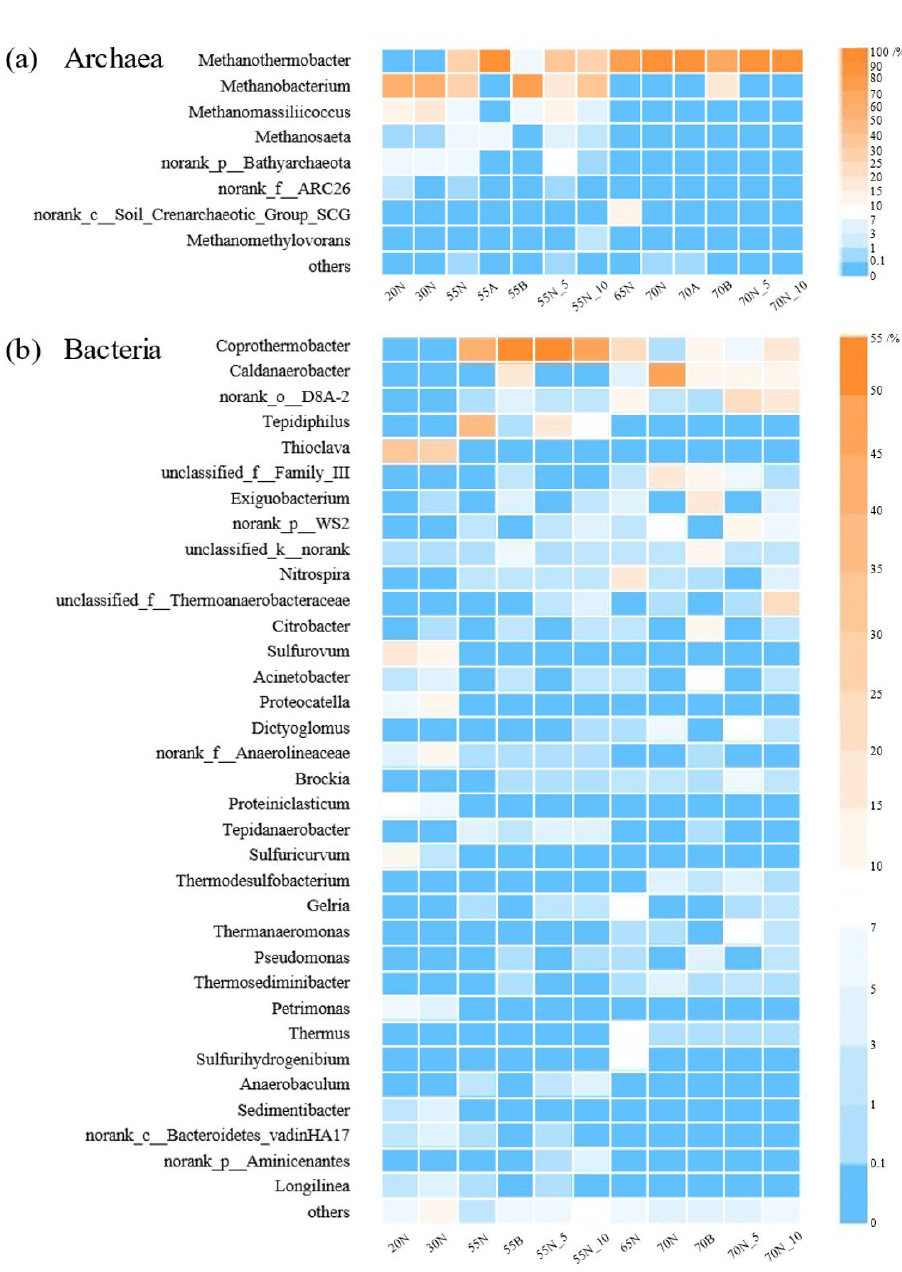
Figure 1. Heatmaps of the microbial communities at the genus level: ( a ) archaea; ( b ) bacteria. The unclassified / no-rank microbial genera in the mixed cultures are marked with their upstream taxonomic name; for example, the no-rank archaea at the genus level within phylum Bathyarchaeota is described as norank p Bathyarchaeota.